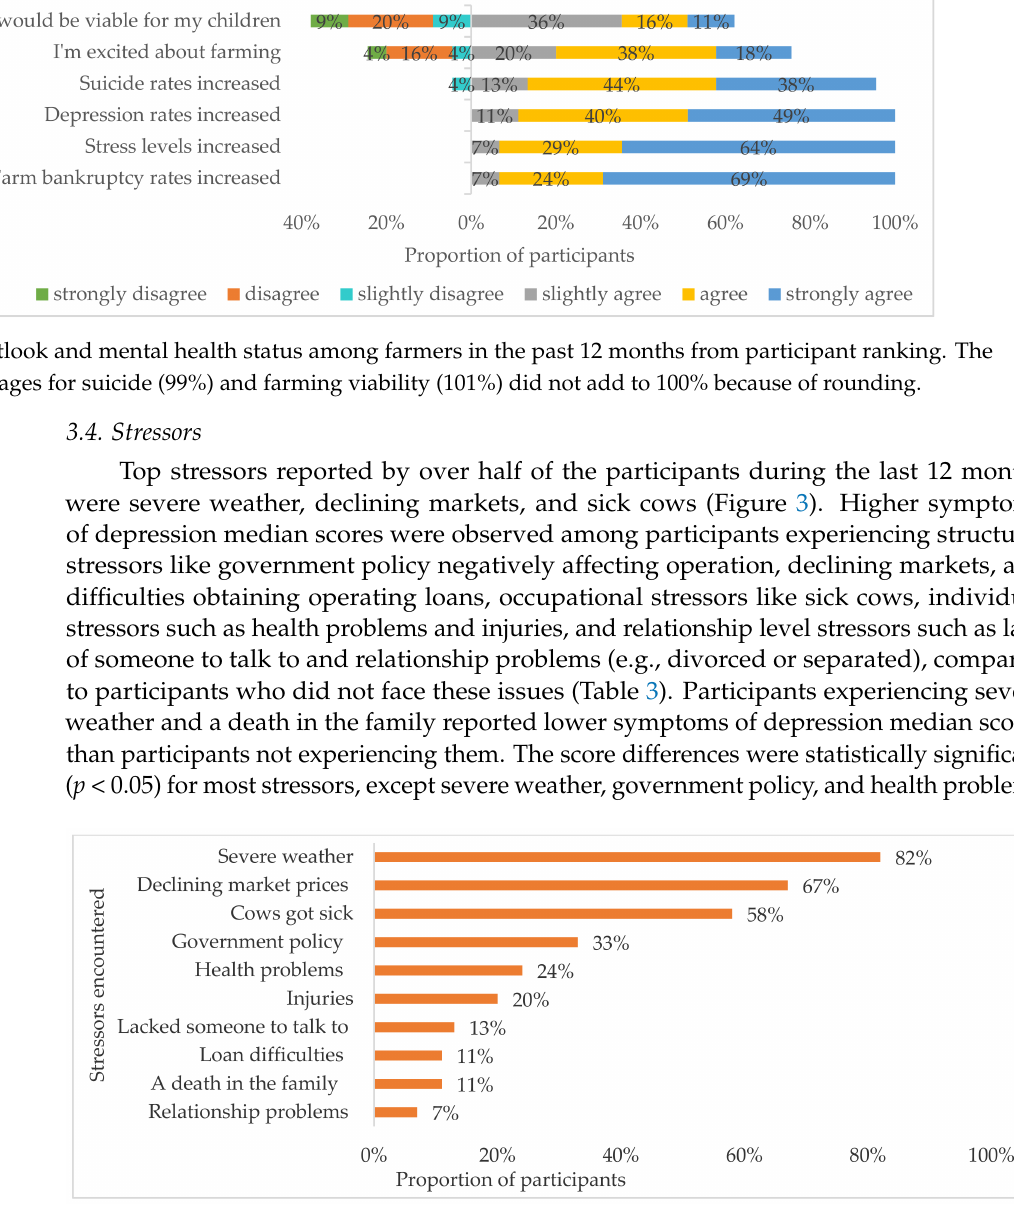
Figure 3. Stressors encountered by participants during the last 12